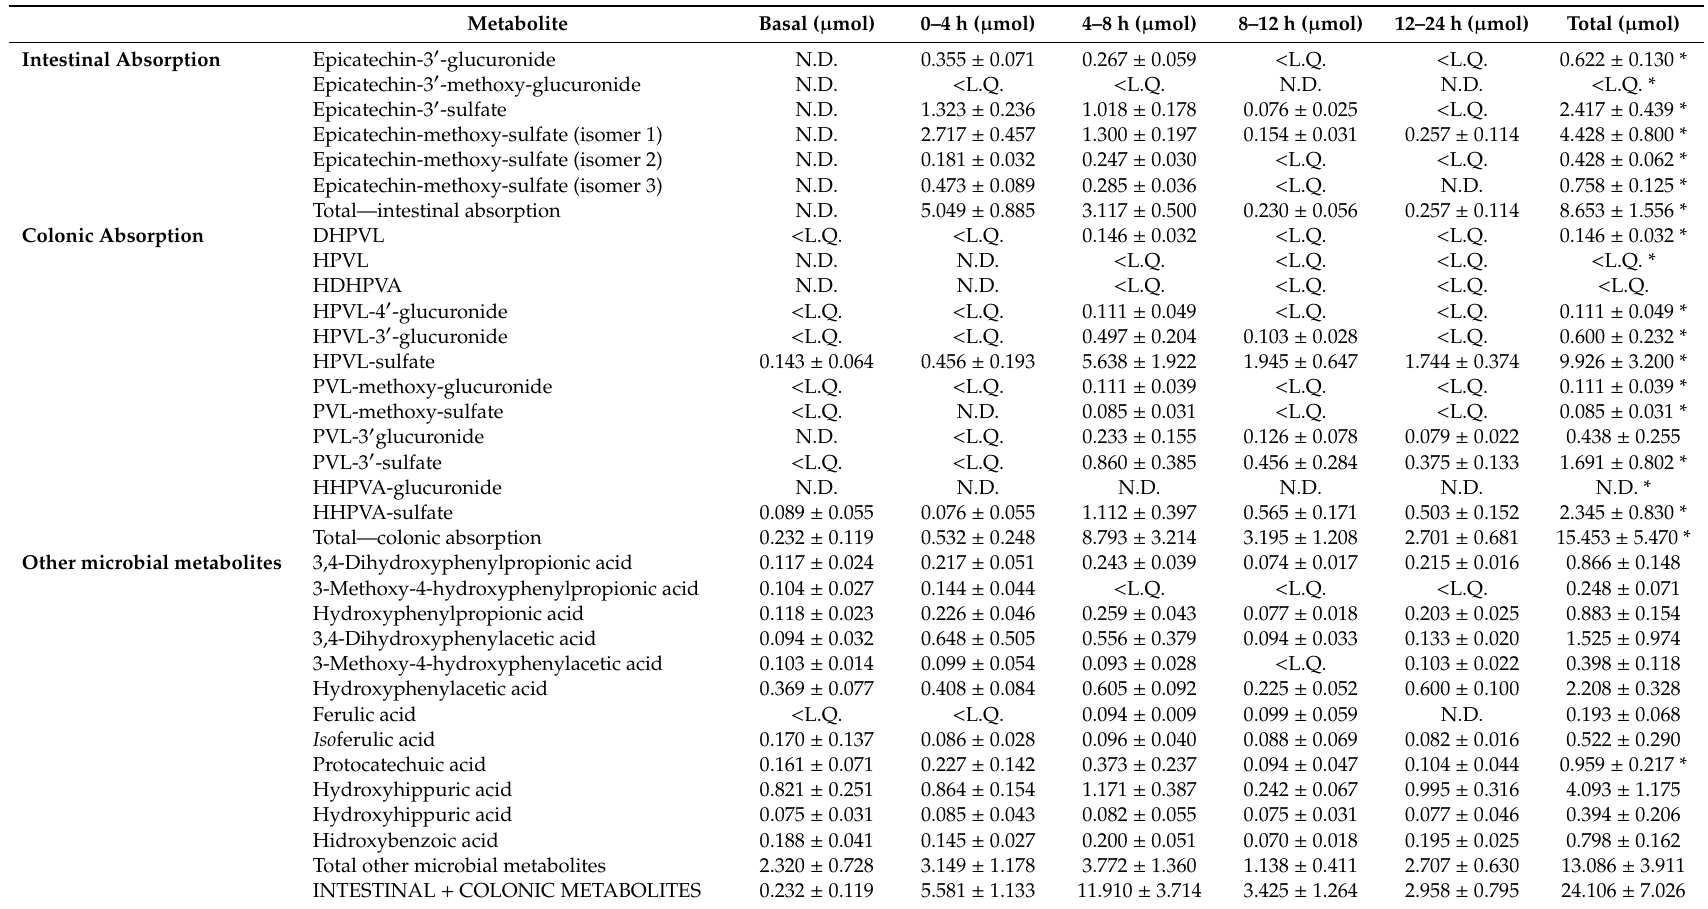
Table 4. Metabolites excreted in urine (from 0 to 24 h) by healthy volunteers after consumption of the conventional soluble cocoa product (CC) containing 19.80 mg of